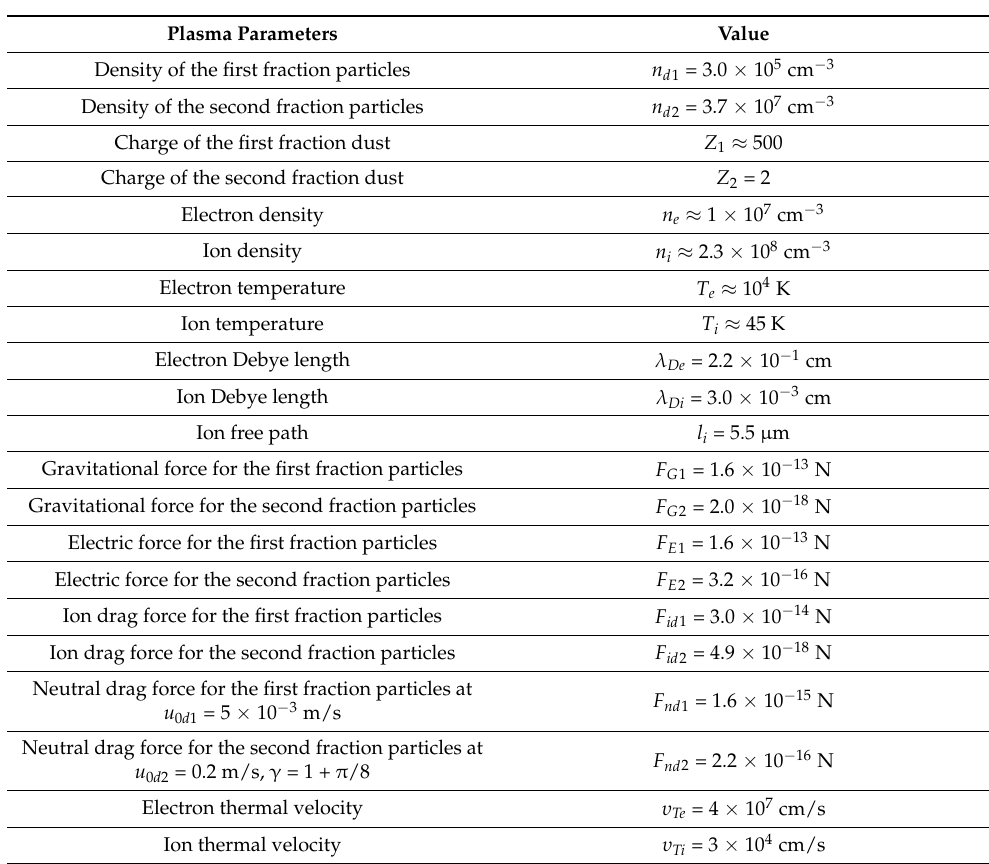
Table 2. Calculated plasma